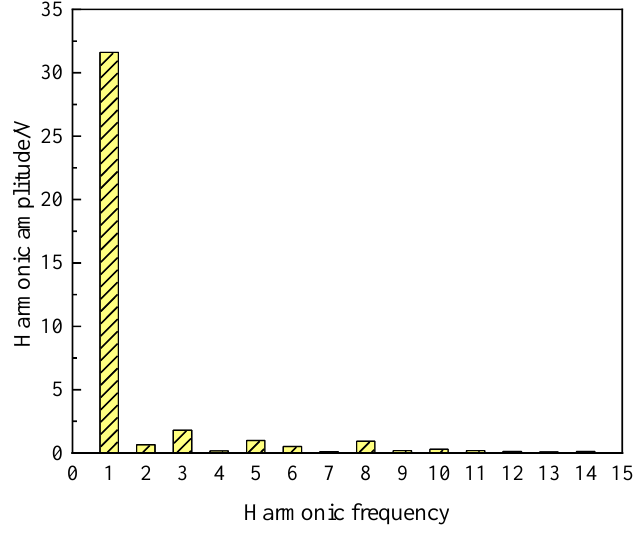
Figure 10. Histogram of the harmonic distribution of the induced electric potential.